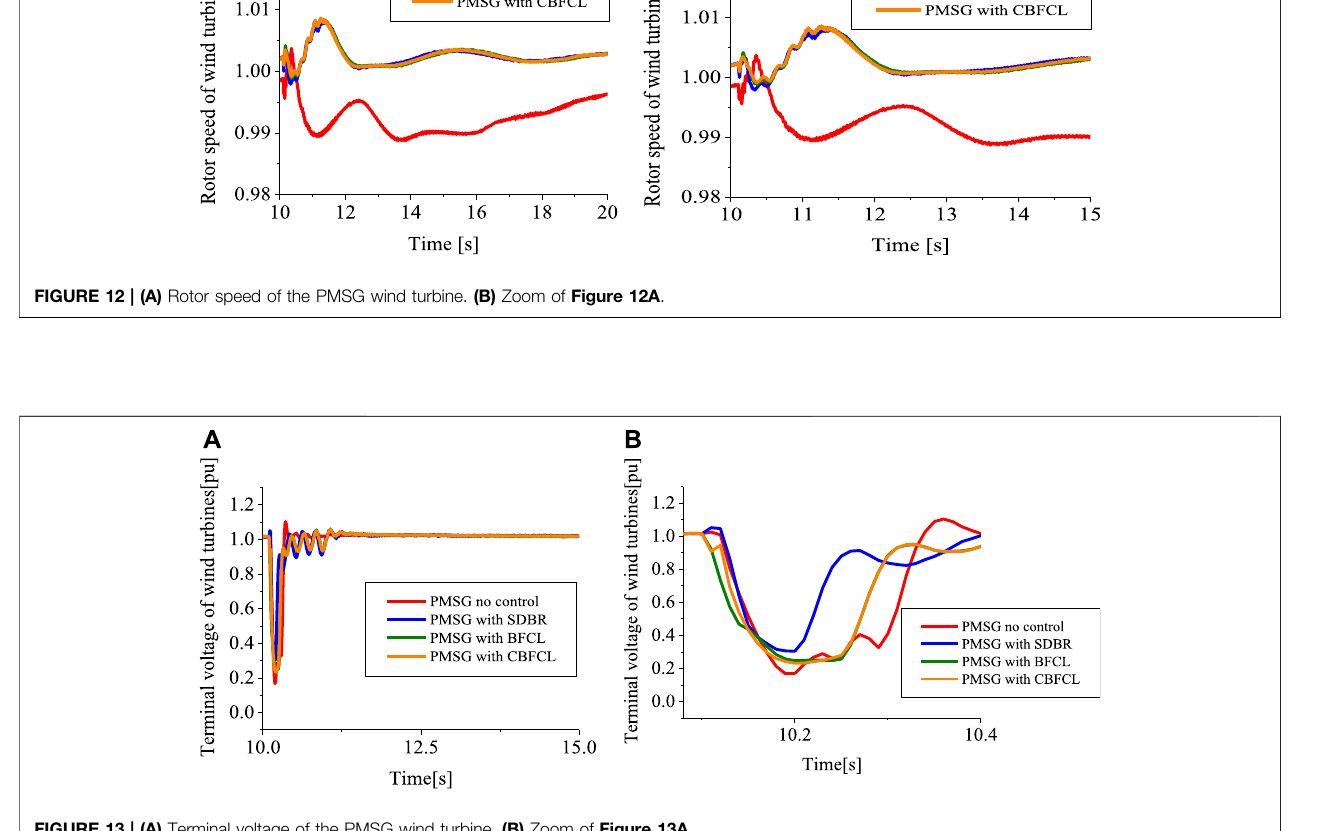
FIGURE 13 | (A) Terminal voltage of the PMSG wind turbine. (B) Zoom of Figure 13A .